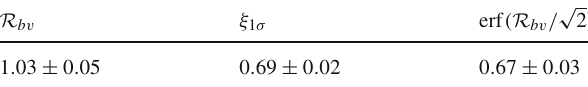
Table 1 In the first column we show the bias-variance ratio, R b v , for unseen data, summarised in Table 2. The uncertainty is estimated by performing a bootstrap sample across fits and replicas and calculating the standard deviation. We see that overall R b v is consistent with 1, within uncertainties. In the second and third columns we compare the measured value of ξ 1 σ and the estimated value from R b v . The two values are consistent, which suggests the approximation that the ratio of uncertaintiesisapproximatelythesameacrossalldataisnotcompletely invalidated